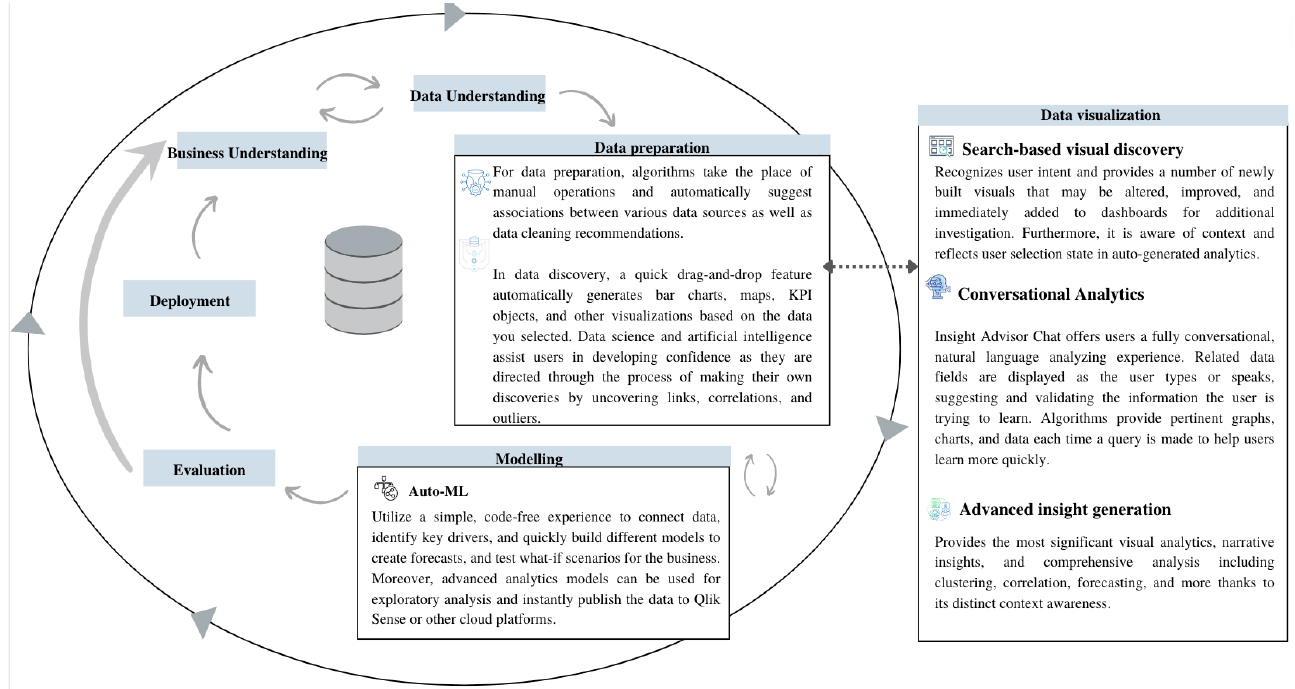
Figure 1. The general structure of the proposed approach.